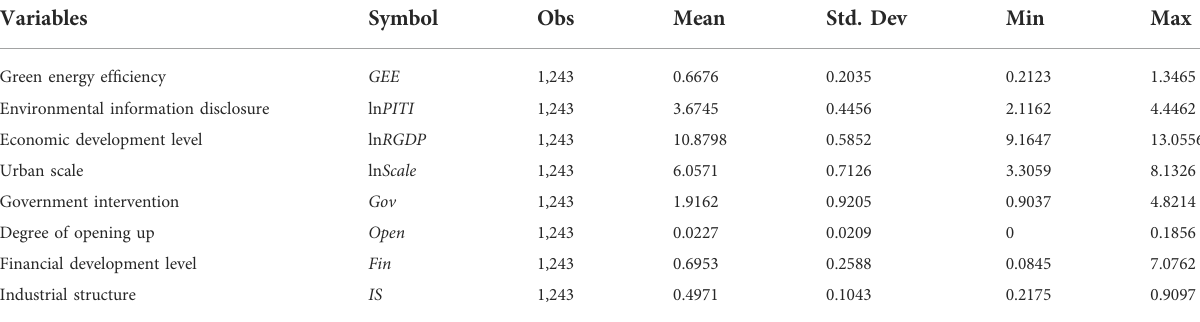
TABLE 2 Statistical description of